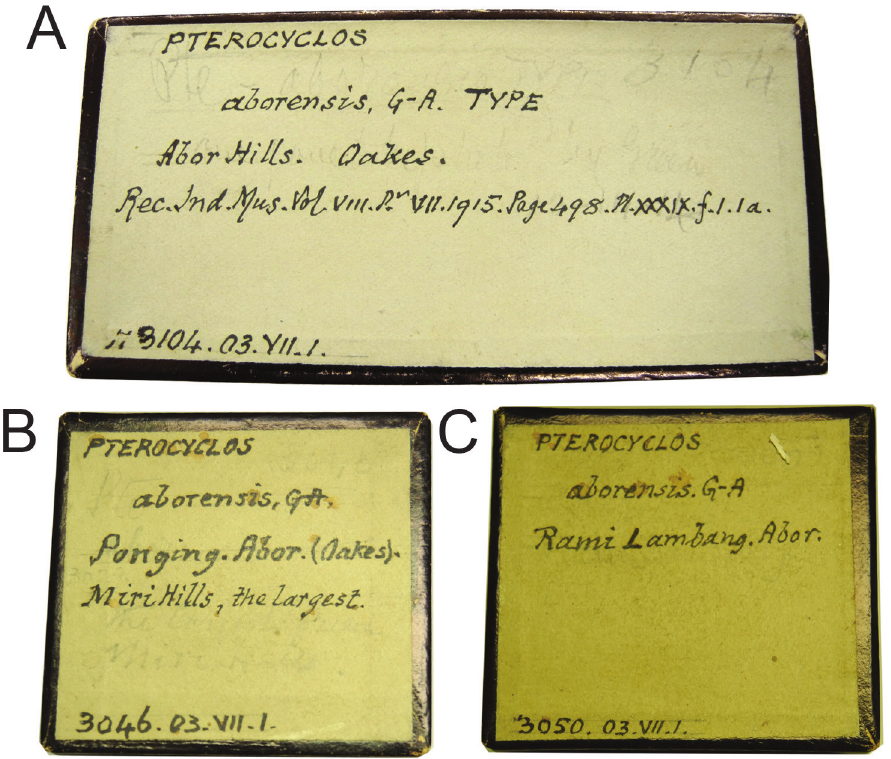
Figure 5. Original labels bearing Godwin-Austen’s handwriting of Pterocyclos aborensis A NHMUK 1903.7.1.3104 with the word “Type” B NHMUK 1903.7.1.3046, and C NHMUK